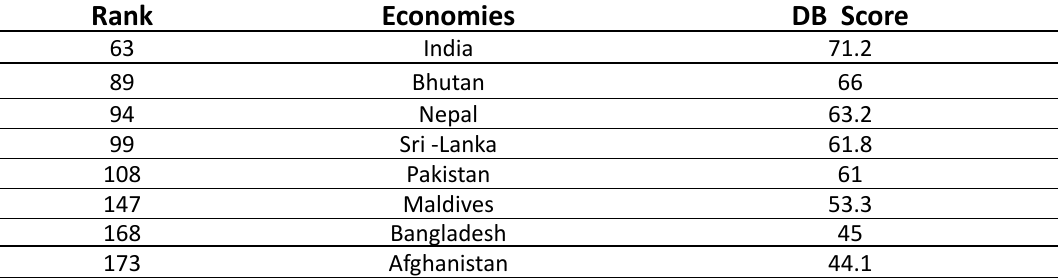
Table 1: Doing Business Score of Nepal and South Asian Countries, 2020